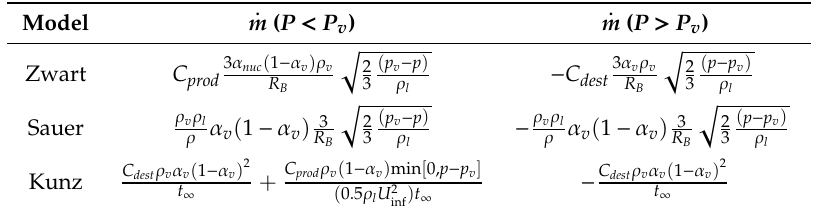
Table 2. Mathematical expressions of the cavitation